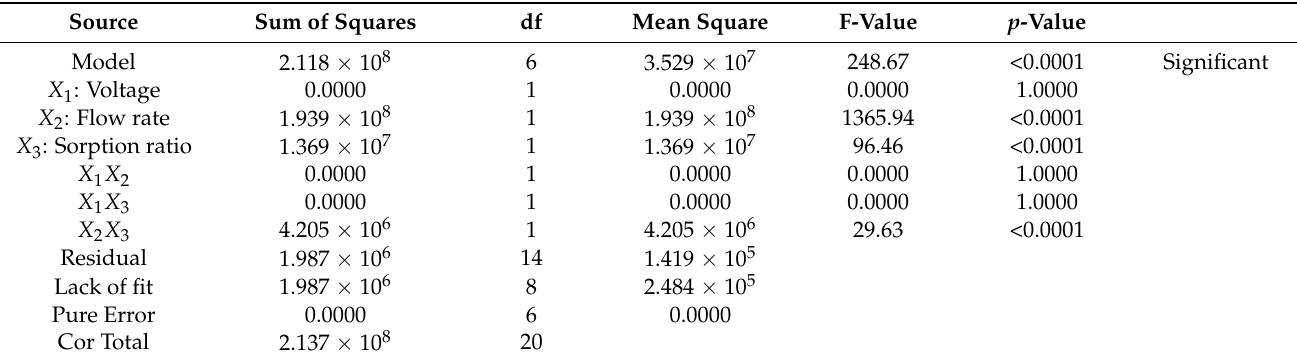
Table 8. ANOVA for the response surface 2FI model.